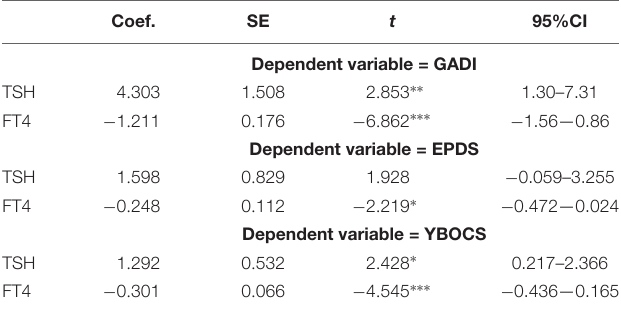
TABLE 3 | Results from longitudinal bivariate models for GADI, EPDS, and YBOCS as dependent variables with time, TSH, and FT4 as independent variables.